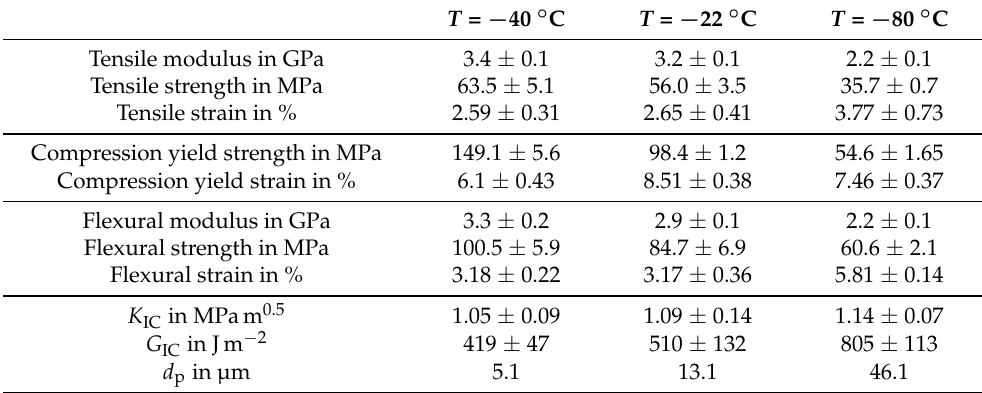
Table A1. Overview of tensile, compression, flexural, and fracture toughness properties of Argopox (average ± standard deviation) at T = − 40°C, 22°C, and